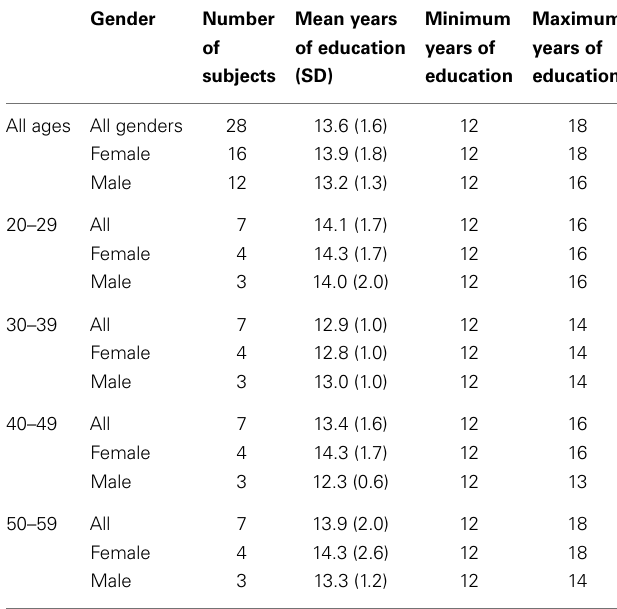
Table 2 | Subjects’ demographic